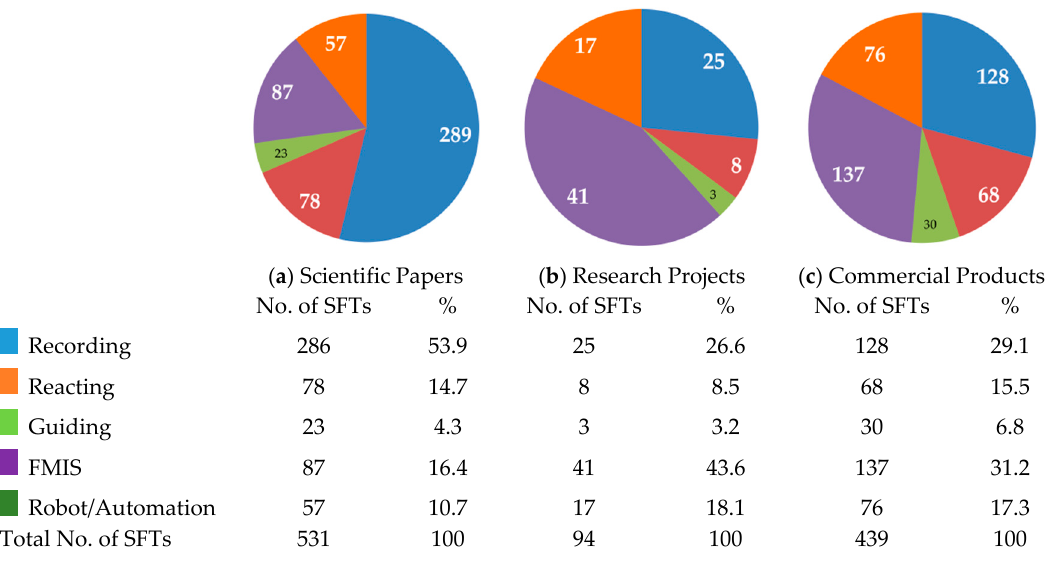
Figure 3. Allocation of the identified smart farming technologies (SFTs) to each type (recording, reacting, guiding, farm management information systems (FMIS), and robotic/automation systems) based on the classification of Schwarz and Herold [101] modified by the authors in ( a ) scientific papers, ( b ) research projects, and ( c ) commercial products.